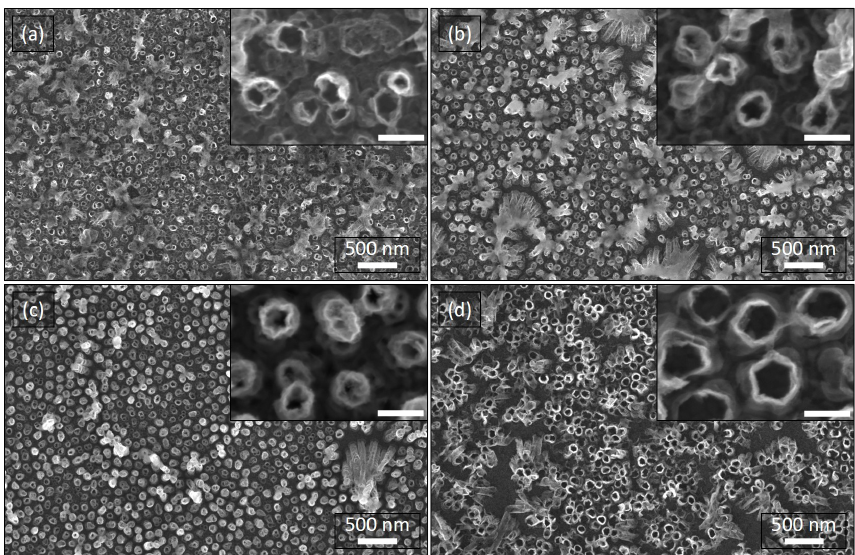
Figure 3. Top-view scanning electron microscope (SEM) micrographs of the dense arrays of Ni NTs vertically-aligned to the Au/Si substrate, prepared under different cathodic reduction potential of the Cu/Ni core/shell NWs (applied versus SCE): ( a ) − 0.95 V (sample S1), ( b ) − 1.00 V (sample S2), ( c ) − 1.05 V (sample S3), and ( d ) − 1.10 V (sample S4). The insets represent corresponding higher magnification